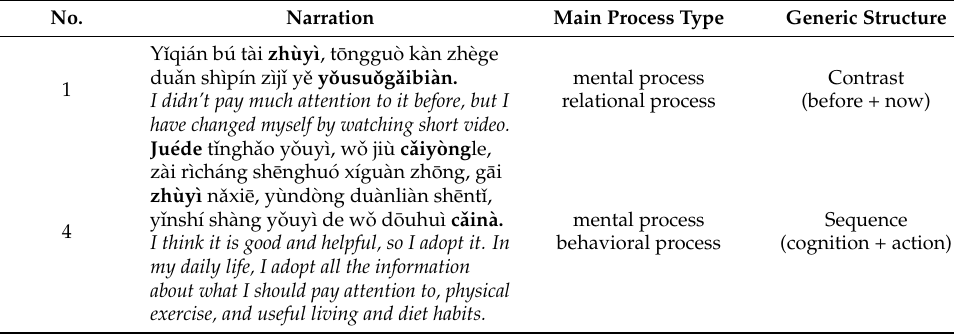
Table 4. Analysis of the interviewees’ narration about cognitive